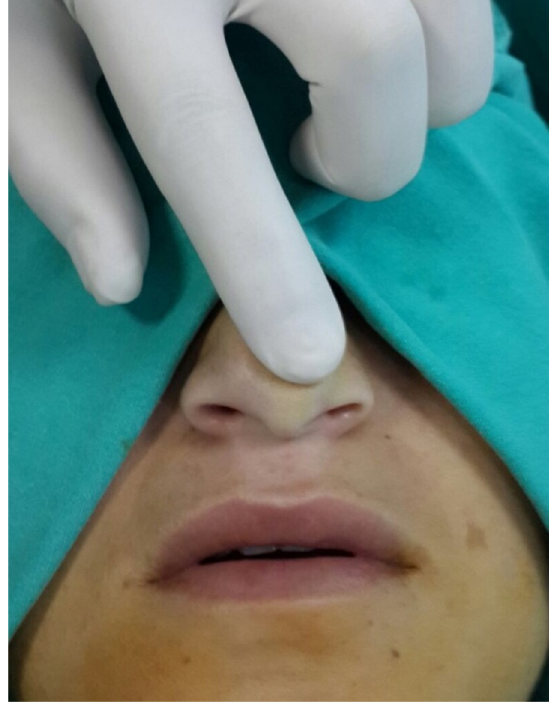
Figure 1 Recoil maneuver.